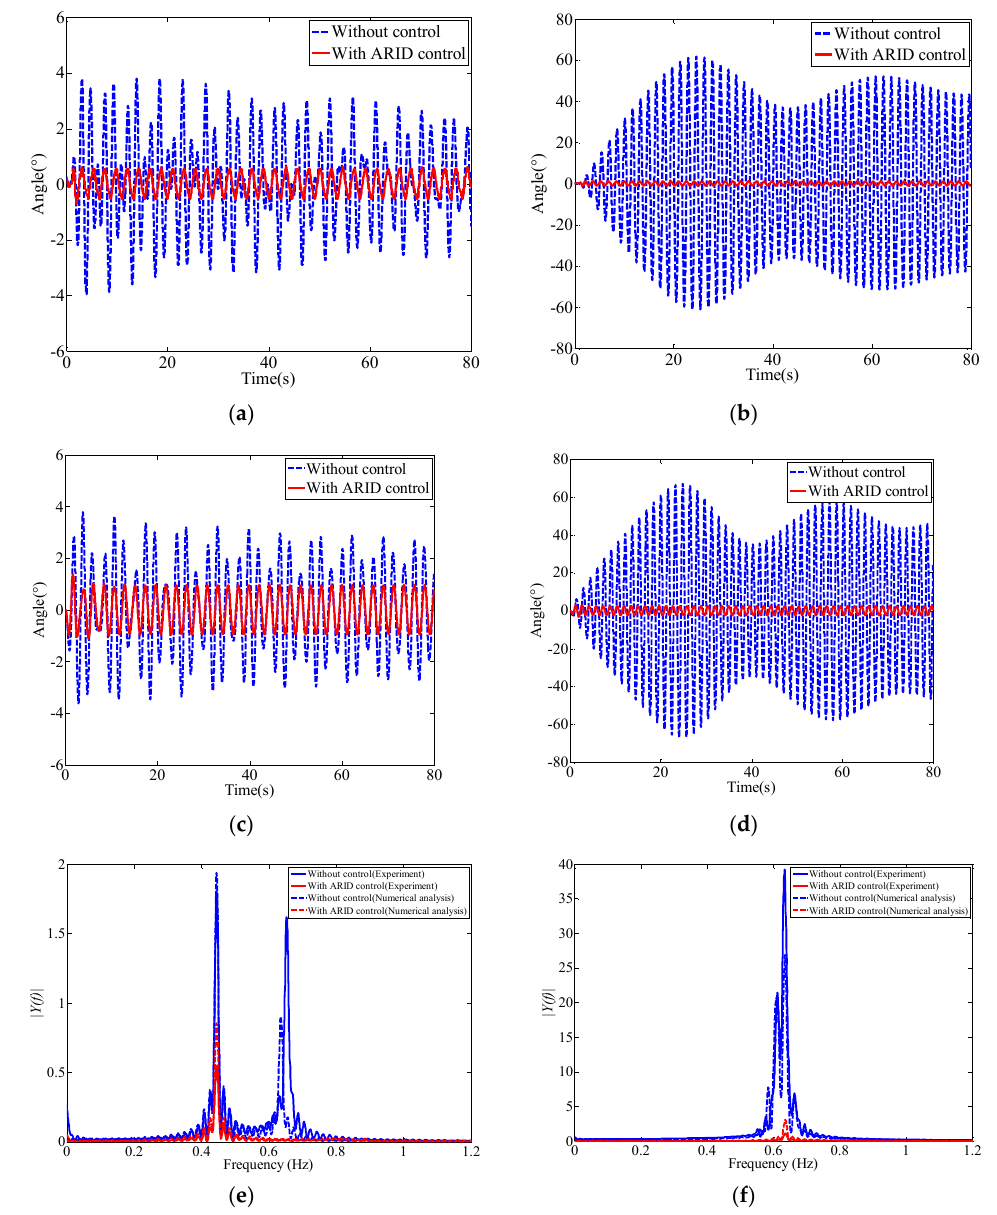
Figure 10. Comparison of experiment and numerical analysis results: ( a ) Experiment swing angle time history of λ = 0.7; ( b ) Experiment swing angle time history of λ = 1; ( c ) Numerical analysis swing angle time history of λ = 0.7; ( d ) Numerical analysis swing angle time history of λ = 1; ( e ) Amplitude-frequency curve of λ = 0.7; ( f ) Amplitude-frequency curve of λ = 1.